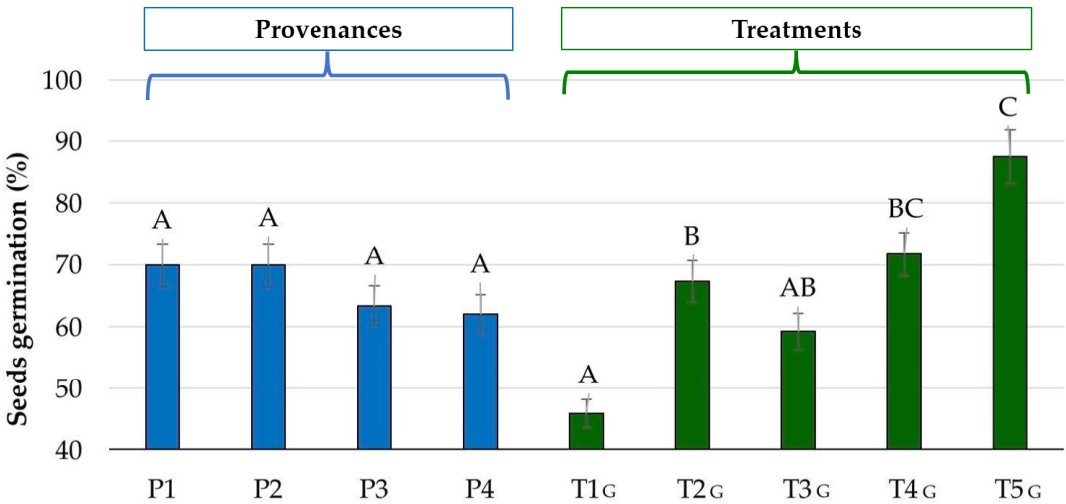
Figure 6. Percentage of seed germination for provenances and G treatments (mean ± SE; n = 50). The means represented with blue color reflect the influence of the provenance (P1 — M ăria Mică, P2— Făina, P3—Aluniș, and P4 —Putnișoara), regardless of the treatment applied; the means represented with green color reflect the influence of the G treatment (T1 G (Control), T2 G (1 Gy-31 min), T3 G (1.5 Gy-46 min), T4 G (2 Gy-62 min), and T5 G (6 Gy-186 min)), regardless of the provenance. Different (upper case) letters at the top of the bars indicate statistically significant differences between prov- enances, and respectively treatments, according to Duncan’s MRT test ( p < 0.05).